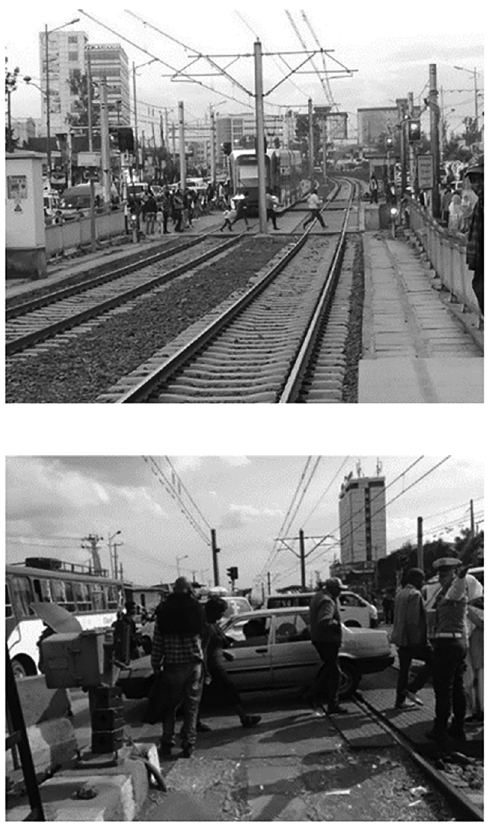
Figure 2. Traf fi c of fi cer